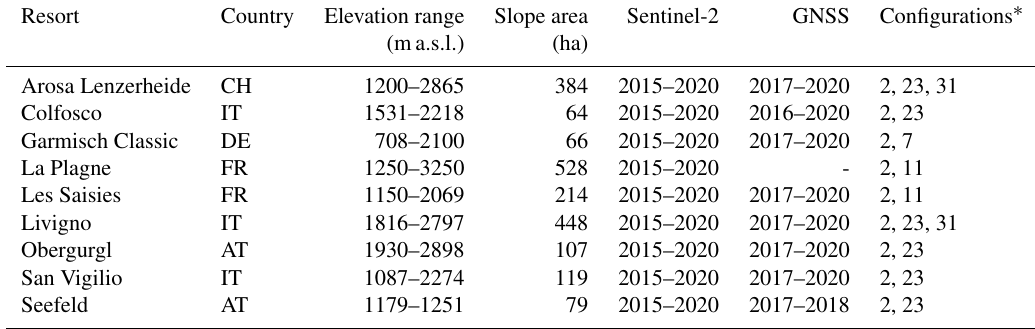
Table 1. Overview of the nine PROSNOW ski resorts, the period of available Sentinel-2 and measured GNSS snow depth data, and the used snow management configurations for the simulations based on the paper by Hanzer et al. (2020).